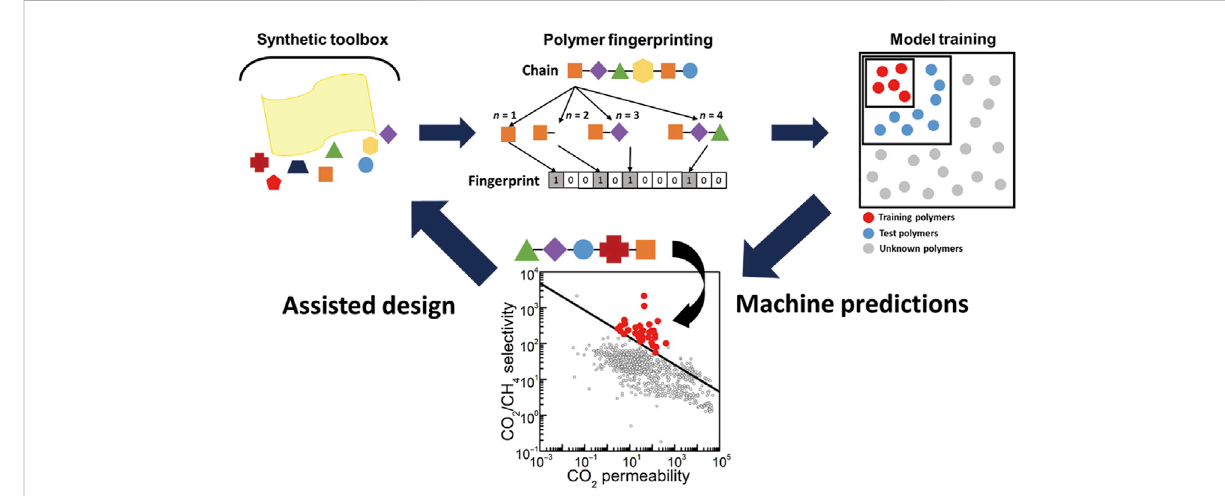
FIGURE 7 Assisted design of high-performance polymer membranes (Barnett et al.,